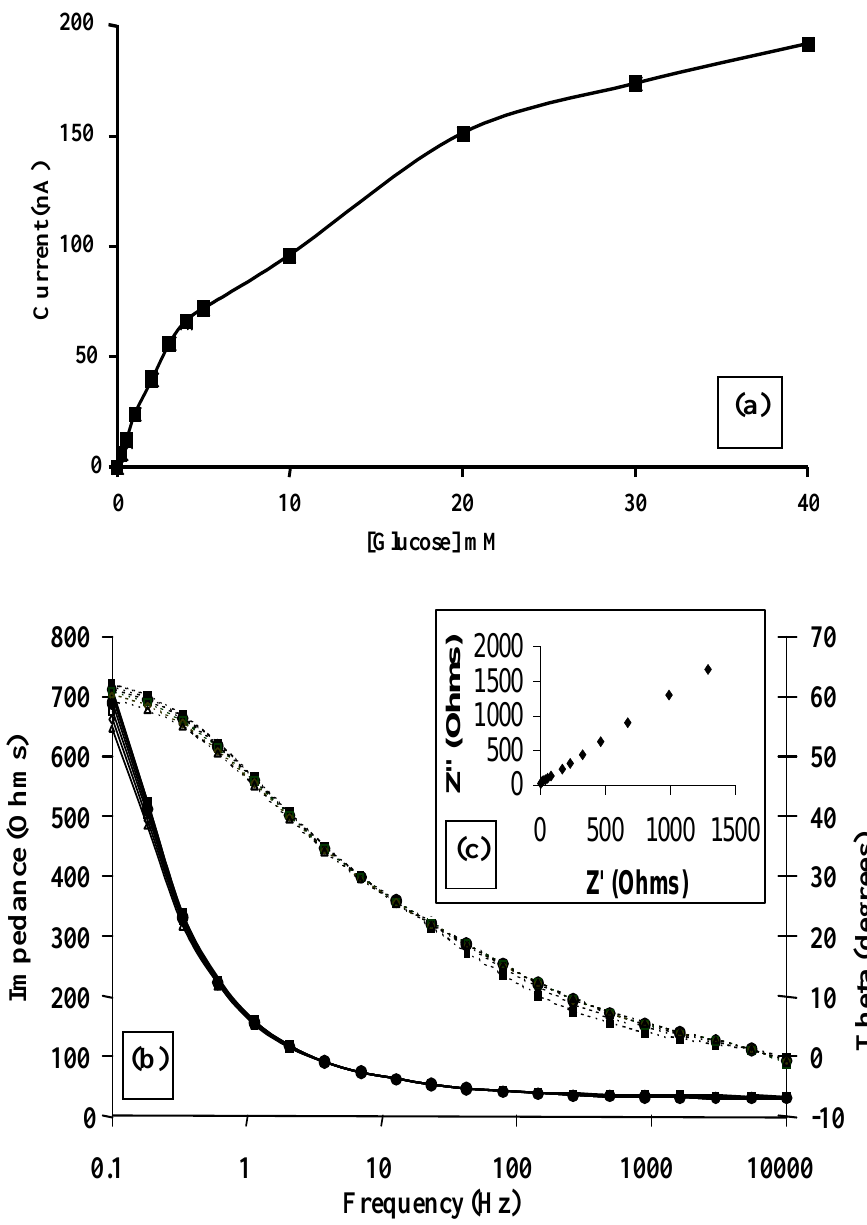
Figure 11. (a) Amperometric glucose calibration curve for poly(aniline)/glucose oxidase microelectrode array. (b) Total impedance (solid line) and phase angle (dashed line) of microelectrode arrays immersed in glucose/phosphate buffer solutions. Concentration of glucose: 0 mM (  ), 1 mM (  ), 5 mM (  ), 10 mM (*), 20 mM ( ), 30 mM (  ), 40 mM (×)—N.B. Plots are seen to converge due to scale utilised. (c) Complex plane plot for a microelectrode array in 20 mM glucose. (d) Percentage change in impedance for microelectrode arrays in various concentrations of glucose versus phosphate buffer. Concentration of glucose: 1 mM (  ), 5 mM (  ), 10 mM (  ), 20 mM ( ), 30 mM (  ), 40 mM (×). (e) Calibration plot of impedance change versus glucose concentration for a 20 seconds sonicated GOD